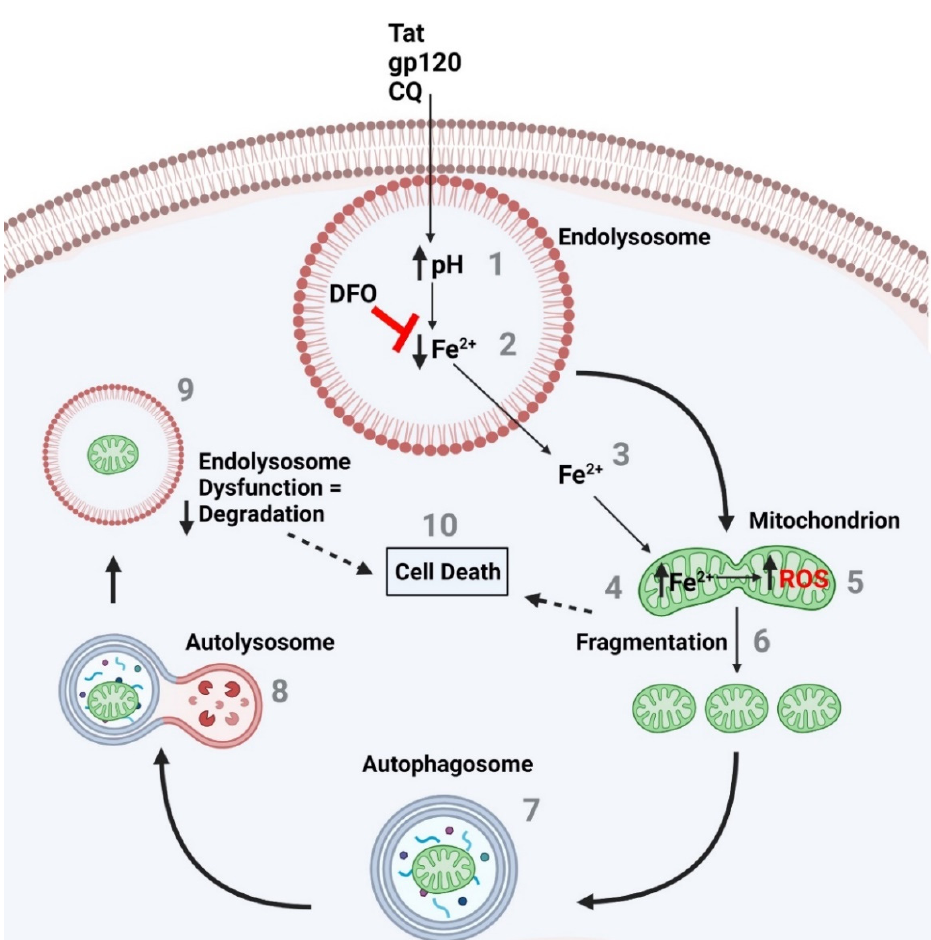
Figure 10. The endolysosome ferrous iron efflux induced by CQ-, Tat-, and gp120-induced de- acidification of endolysosomes increases mitochondrial ROS and fragmentation, autophagy activation, and increased cell death. ( 1 ) CQ and the HIV-1 proteins Tat and gp120 increased endolysosome pH, which is known to ( 2 ) induce a decrease in endolysosome Fe 2+ levels and ( 3 ) an efflux in Fe 2+ from endolysosomes into the cytosol and ( 4 ) an increase in mitochondrial Fe 2+ and ( 5 ) ROS levels. The effects on mitochondrial ROS levels result in ( 6 ) the fragmentation of mitochondria and the ( 7 ) activation of autophagy, as seen by the formation of autophagosomes and ( 8 ) the fusion of autophagosomes with endolysosomes (autolysosomes). ( 9 ) Damaged mitochondria then appear in endolysosomes for degradation; however, the endolysosome pH is elevated, and as demonstrated previously, inactive degradation enzymes due to an elevated pH means the endolysosome enzymes are not degrading the damaged mitochondria as needed. ( 10 ) This may lead to cell death. In addition, the fragmented mitochondria result in a decrease in bioenergetics and may result in cell death as well. The endolysosome-specific iron chelator deferoxamine DFO blocks the CQ-, Tat-, and gp120- induced endolysosome iron efflux, the increase in mitochondrial iron and ROS levels, the increase in fragmentation, as well as the increase in cell